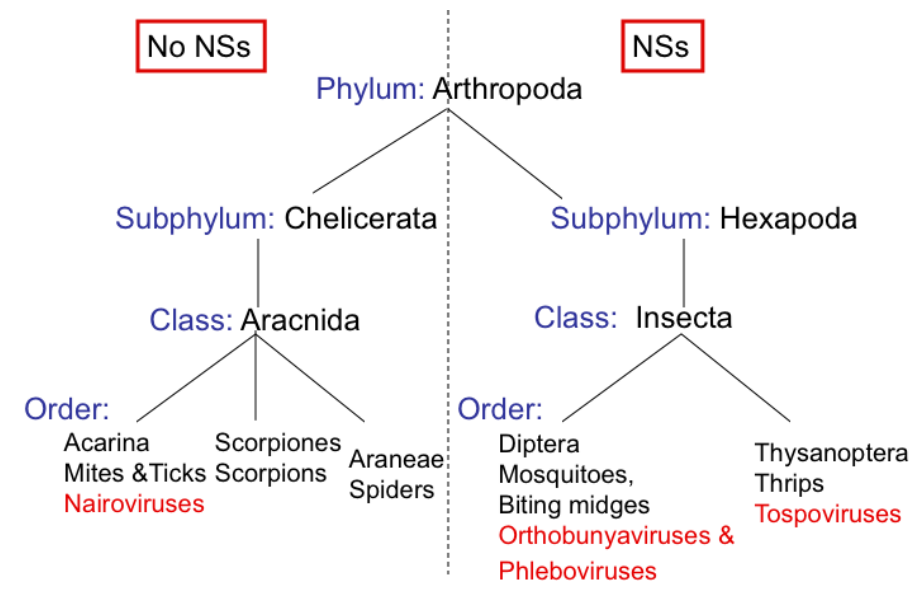
Figure 2. Phylogeny of arthropod vectors used by the Bunyaviridae . Bunyaviruses whose life cycle includes an insect vector (phleboviruses, orthobunyaviruses, and tospoviruses) encode a NSs protein either through an ambisense coding mechanism or in a reading frame that overlaps with that of the nucleocapsid (N). In contrast, bunyaviruses that do not use insect vectors (nairoviruses and hantaviruses) lack a NSs